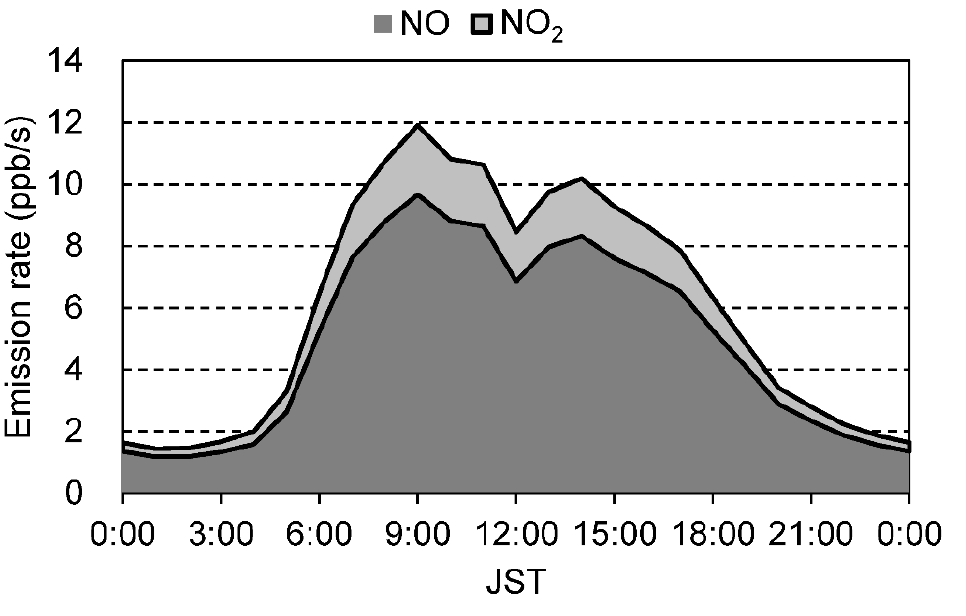
Figure 3. NOx emission rate of road from 0:00 to 24:00 23 August 2010.